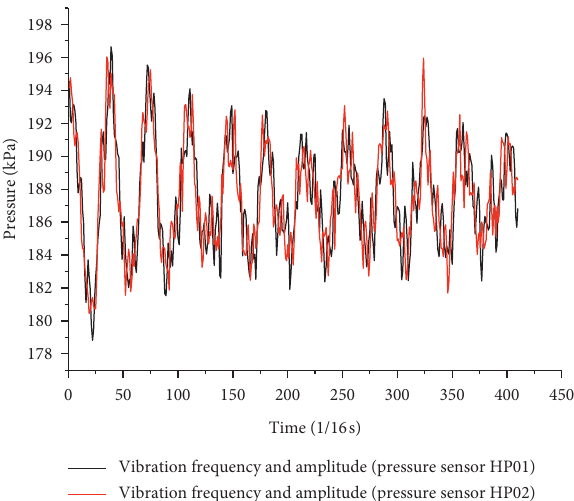
Figure 15: Change of vibration frequency and amplitude with water level